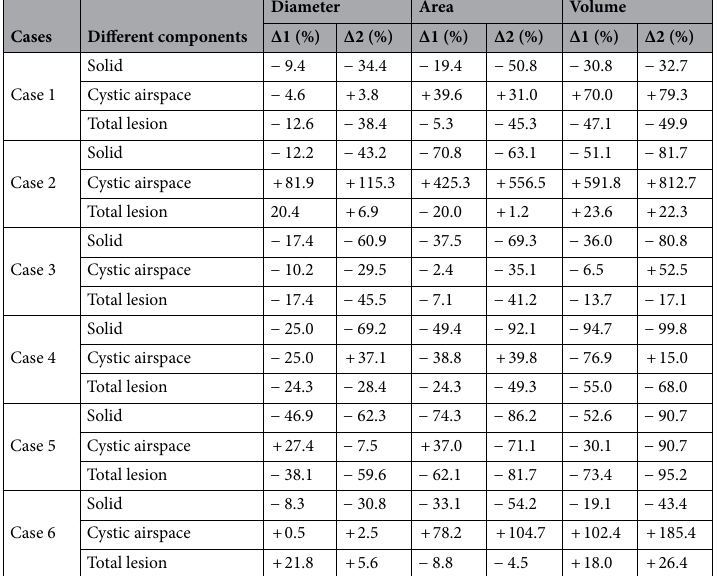
Table 2. Changes in the three different components on serial CT images. Δ1 =